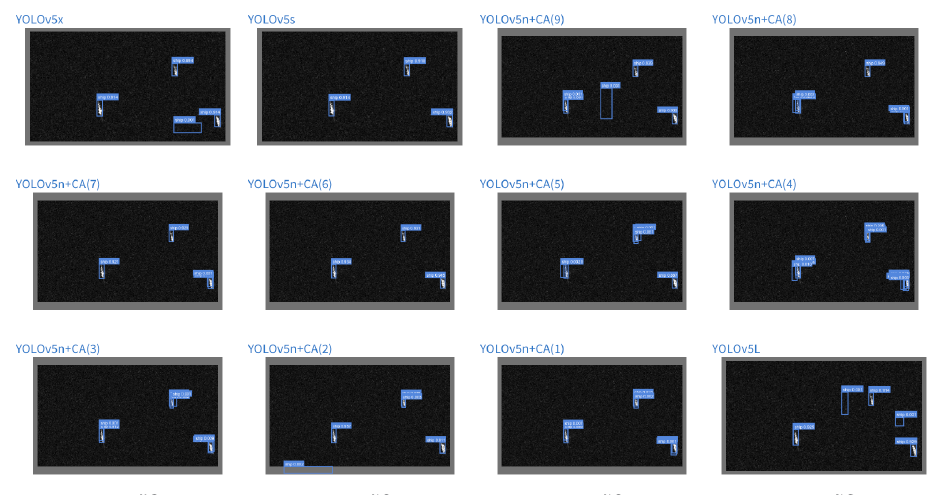
Figure 11. Visualization of a typical offshore scenario during the testing process for experiment. Each subgraph represents the Bbox generation of the scene by different models before NMS.